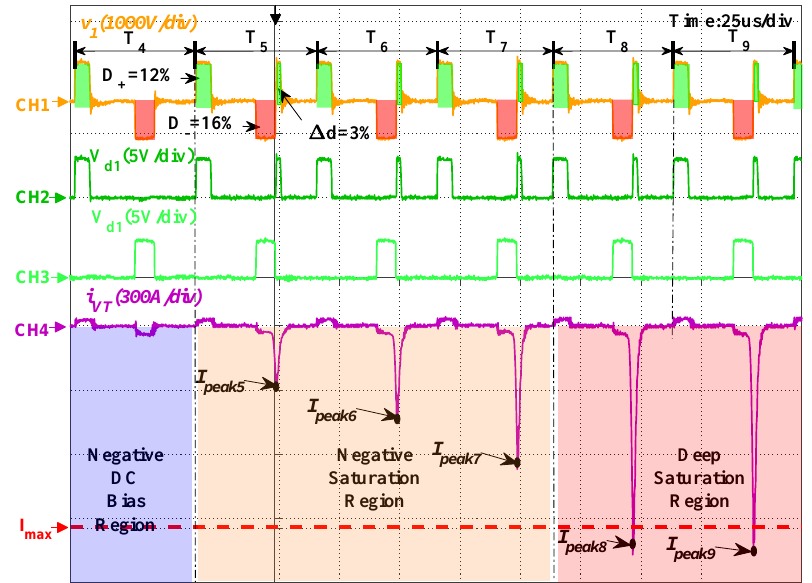
Figure 16. The key waveform of negative DC